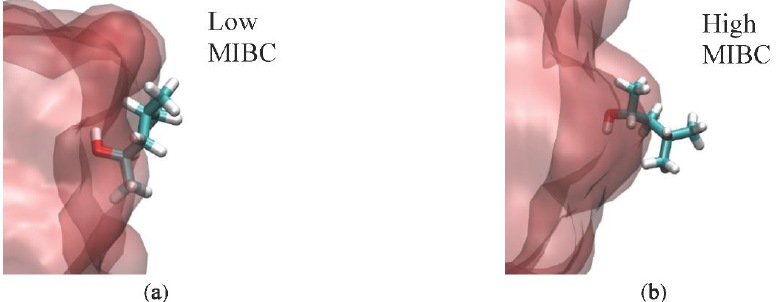
Figure 4. Spatial orientation of MIBC molecules at the liquid – water interfaces. ( a ) Parallel to the interface for low concentration and ( b ) orthogonal to the interface for high concentration. Both are in pure water and in 1 M NaCl solution.